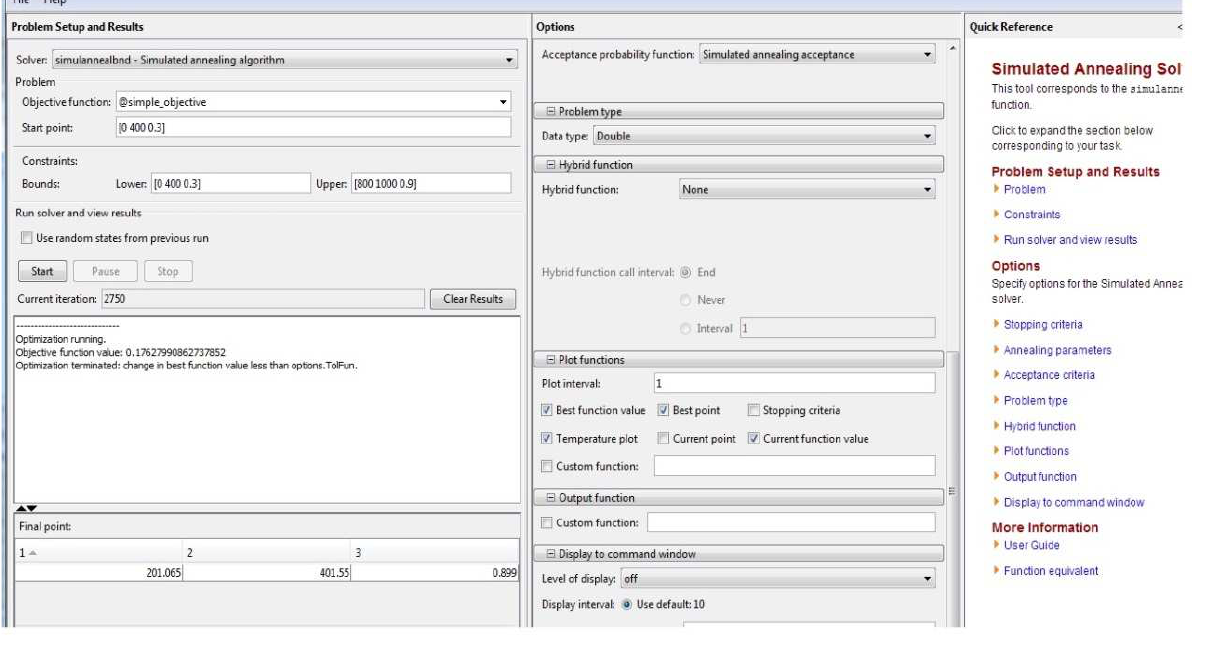
Fig. 13. Applying of Simulated Annealing Algorithm (R